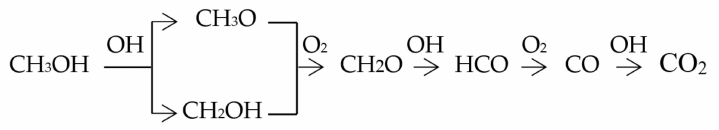
Figure 5. Combustion reaction scheme of methanol fuel.